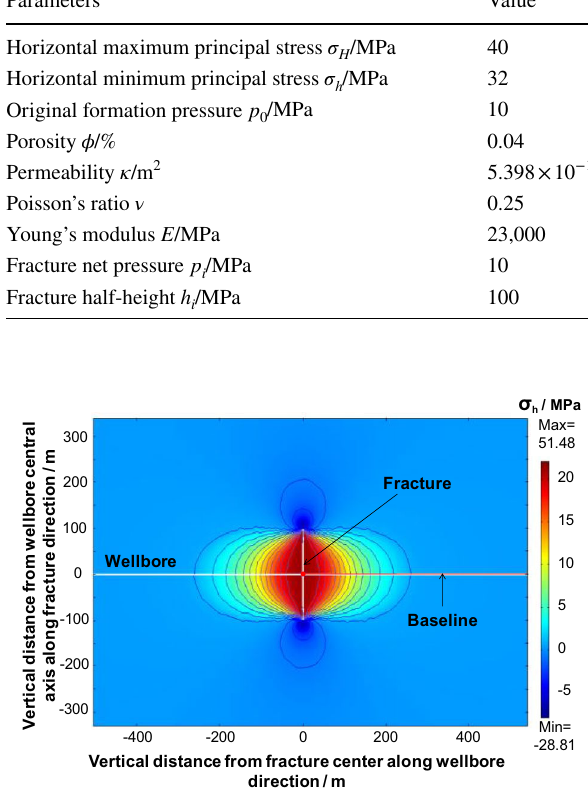
Fig. 3 The minimum horizontal principal stress distribution of a sin- gle fracture in induced stress field on horizontal plane (the numbers in the colour bar indicate the change of stress